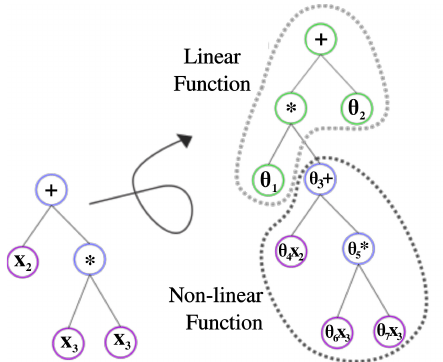
Figure 2. Example of the tree transformation for the LS process ([2], with permission from